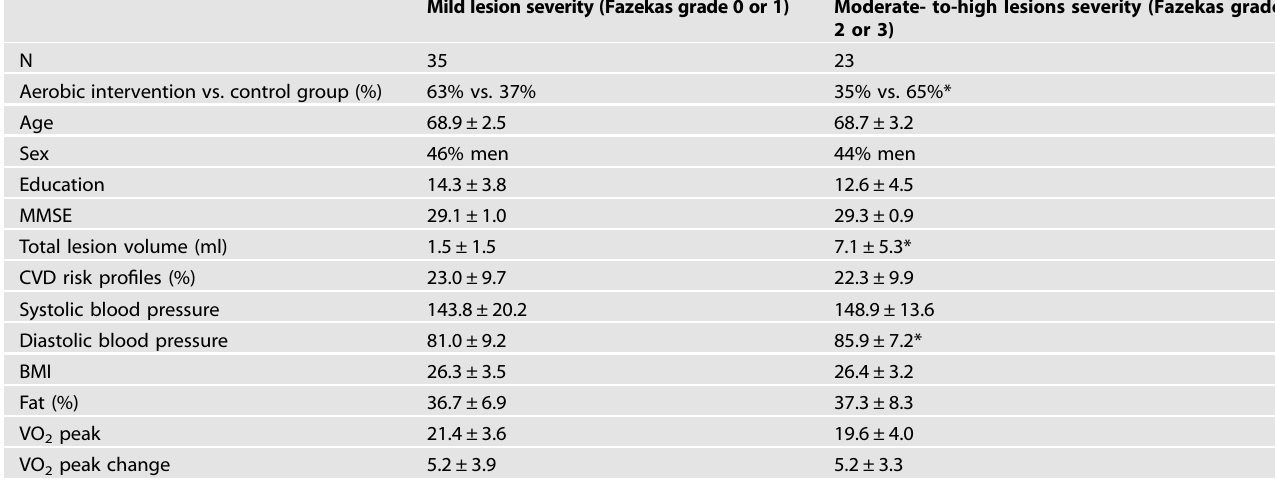
Table 1. Descriptives for mild- and moderate-to-high lesion severity groups, as dichotomized by grades 0 – 1 and 2 – 3 according to the Fazekas lesion grading